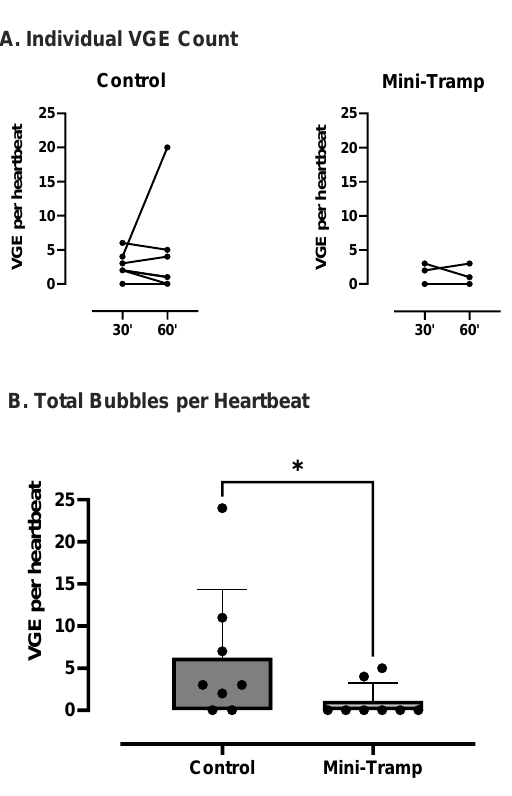
Figure 1. VGE peak count per heartbeat. ( A ) Individual analysis ( n = 8). ( B ) Total bubble count comparing dives with (mini tramp) and without (control) preconditioning. Each diver is his own control. Data are expressed as means ± SD. (* = p < 0.05).